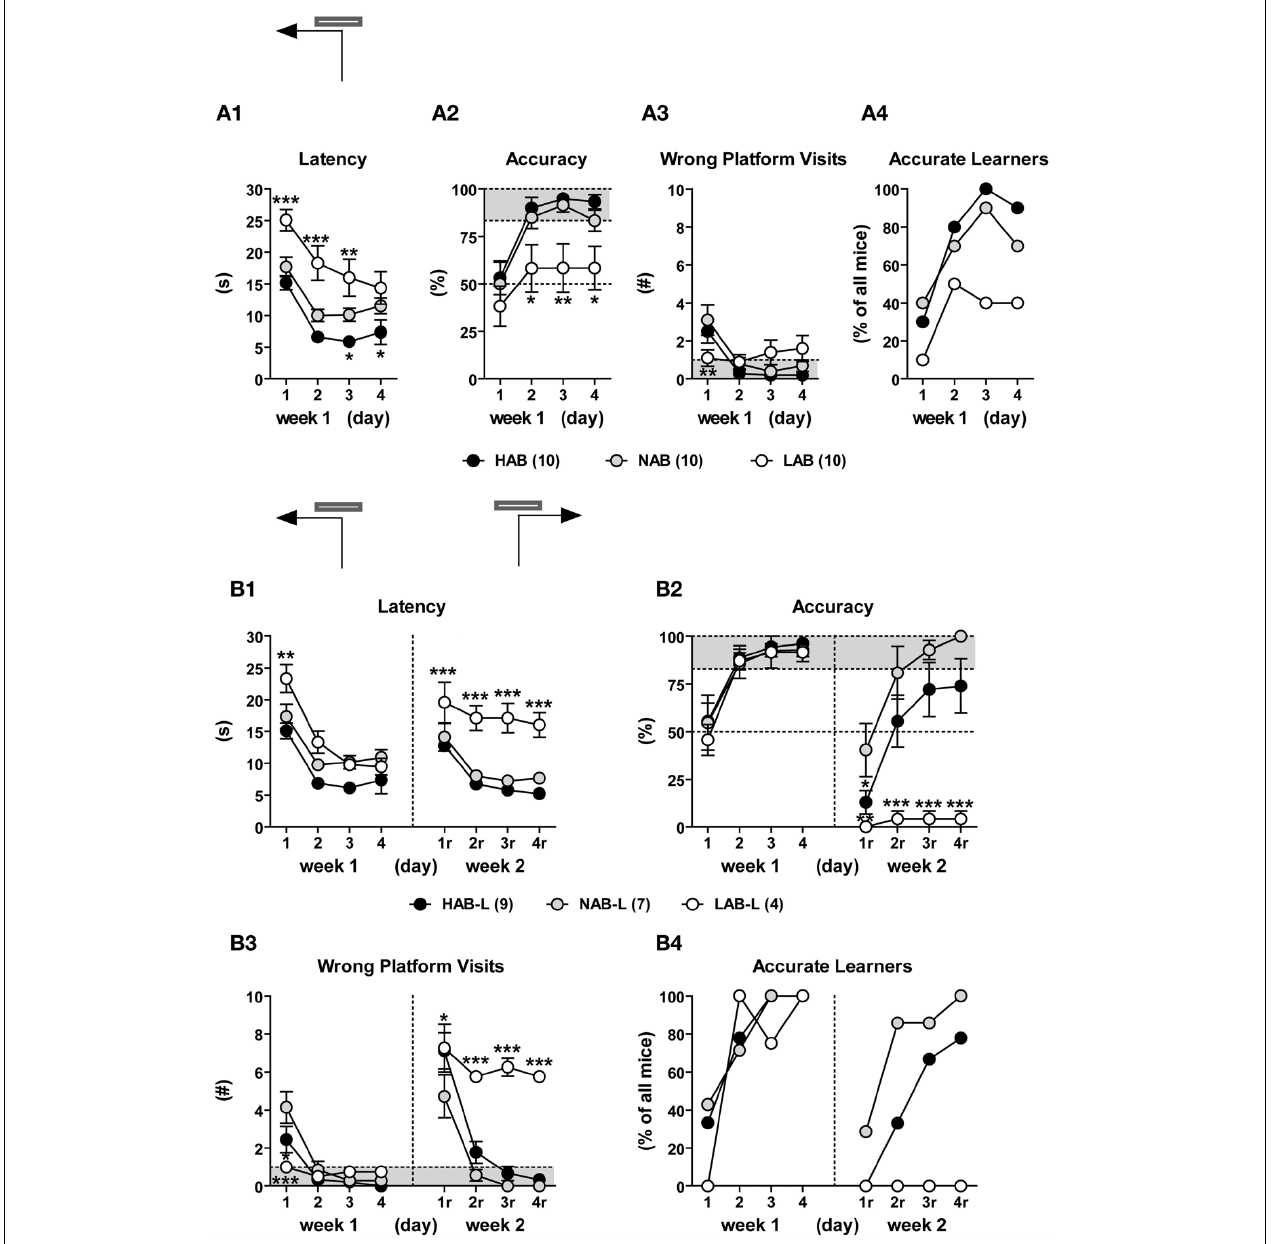
FIGURE 11 | LAB mice were impaired in spatial learning/reversal learning in the water cross-maze (WCM) test. HAB, NAB, and LAB mice were started from the South arm of the WCM (which was resembled to a T-maze by blocking the entrance to the North arm) and trained to navigate to a hidden platform localized in the end of the West arm (d1–d4; week 1) or East arm (d1r–d4r; week 2), with 6 trials per day over the course of 4 consecutive days. Learning performance was described in terms of escape latency (i.e., time spent for reaching the platform), % accuracy (i.e., the percent accurate trials of 6 testing trial), number of wrong platform visits (i.e., number of entries of the outer third of the arm opposite to the goal arm), and number of accurate learners (i.e., animals that perform accurately in at least 5 or 6 trials per day). LAB-I and LAB-S were merged for analysis since both groups did not show differences in their general